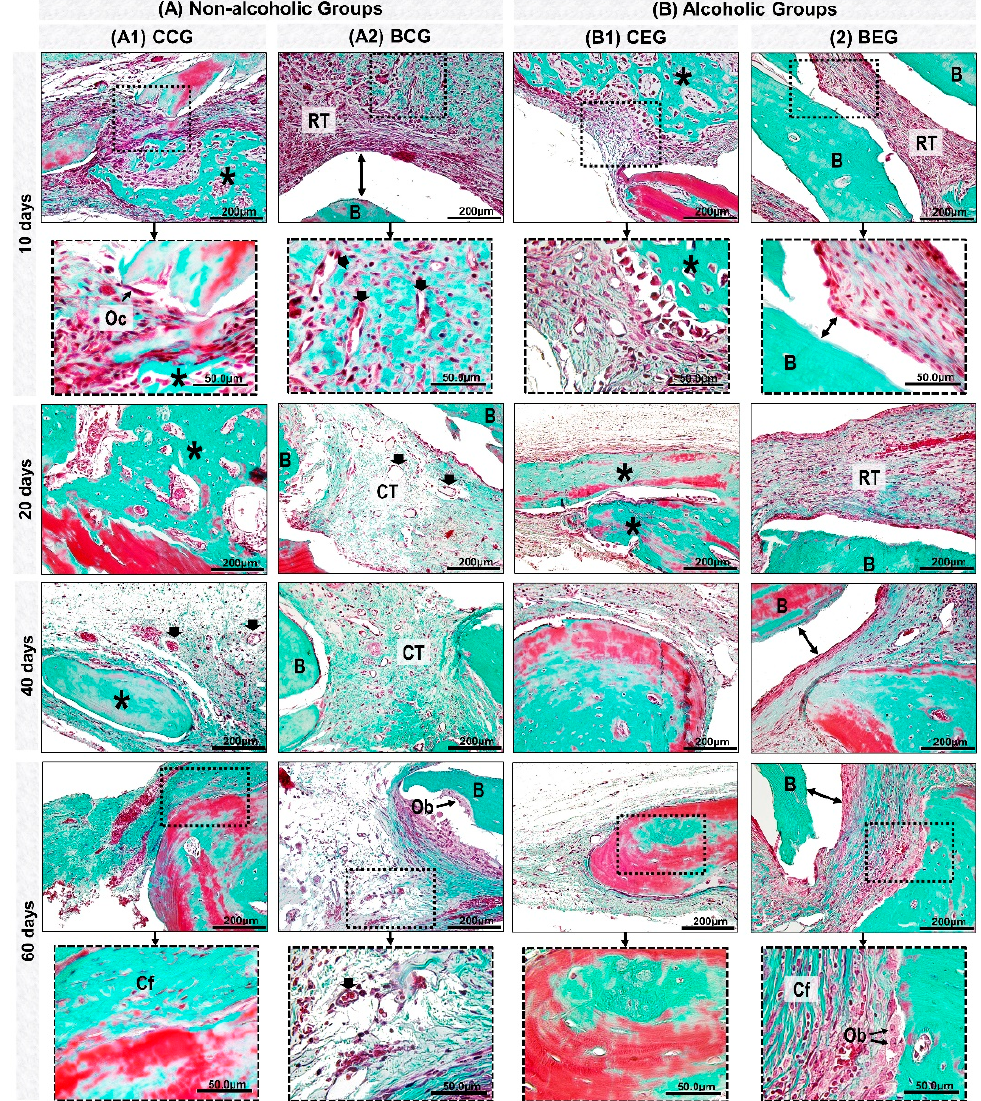
Figure 4. Details of evolution of bone healing of cranial defects created in the Non-Alcoholic ( A ) and Alcoholic ( B ) animals treated with blood clot or biomaterial. ( A1 ) CCG (Non-alcoholic Group; defects filled with blood clot): at 10 days, defects showed trabecular bone formation (asterisk), with the presence of osteoclastic cells (Oc) on the edge of the remaining bone tissue. 20–40 days, the new bone formed showed bone maturation phase surrounded by blood capillaries (black arrow). At 60 days, collagen fibers were arranged in a more regular manner (Cf). ( A2 ) BCG (Non-alcoholic Group: defects filled with biomaterial): at 10 days, defects showed tissue reaction (RT) surrounding the particles of the biomaterial (B); artifacts in histologic sections (double arrow–gap between biomaterial and tissue). Between 20–60 days, connective tissue (CT) presented scarce inflammatory cells with thin and thick collagen fibers, which were parallelly arranged at the end of the experimental period. ( B1 ) CEG (Alcoholic Group; defects filled with blood clot): in the early periods, the defects presented inflammatory cells, decreasing at 40 days. The bone tissue formed at 60 days was predominantly compact and mature. ( B2 ) BEG (Alcoholic Group; defects filled with biomaterial): 10–20 days, sections showed discrete bone formation, and biomaterial particles permeated by reaction tissue. In the later periods, collagen fibers were organized in parallel, and osteoblastic cells (Ob) forming a single cell line adjacent to the matrix. Masson’s Trichrome; original magnification ×40; bar = 100 µm; and Insets, magnified images ×100; bar = 50 µm.